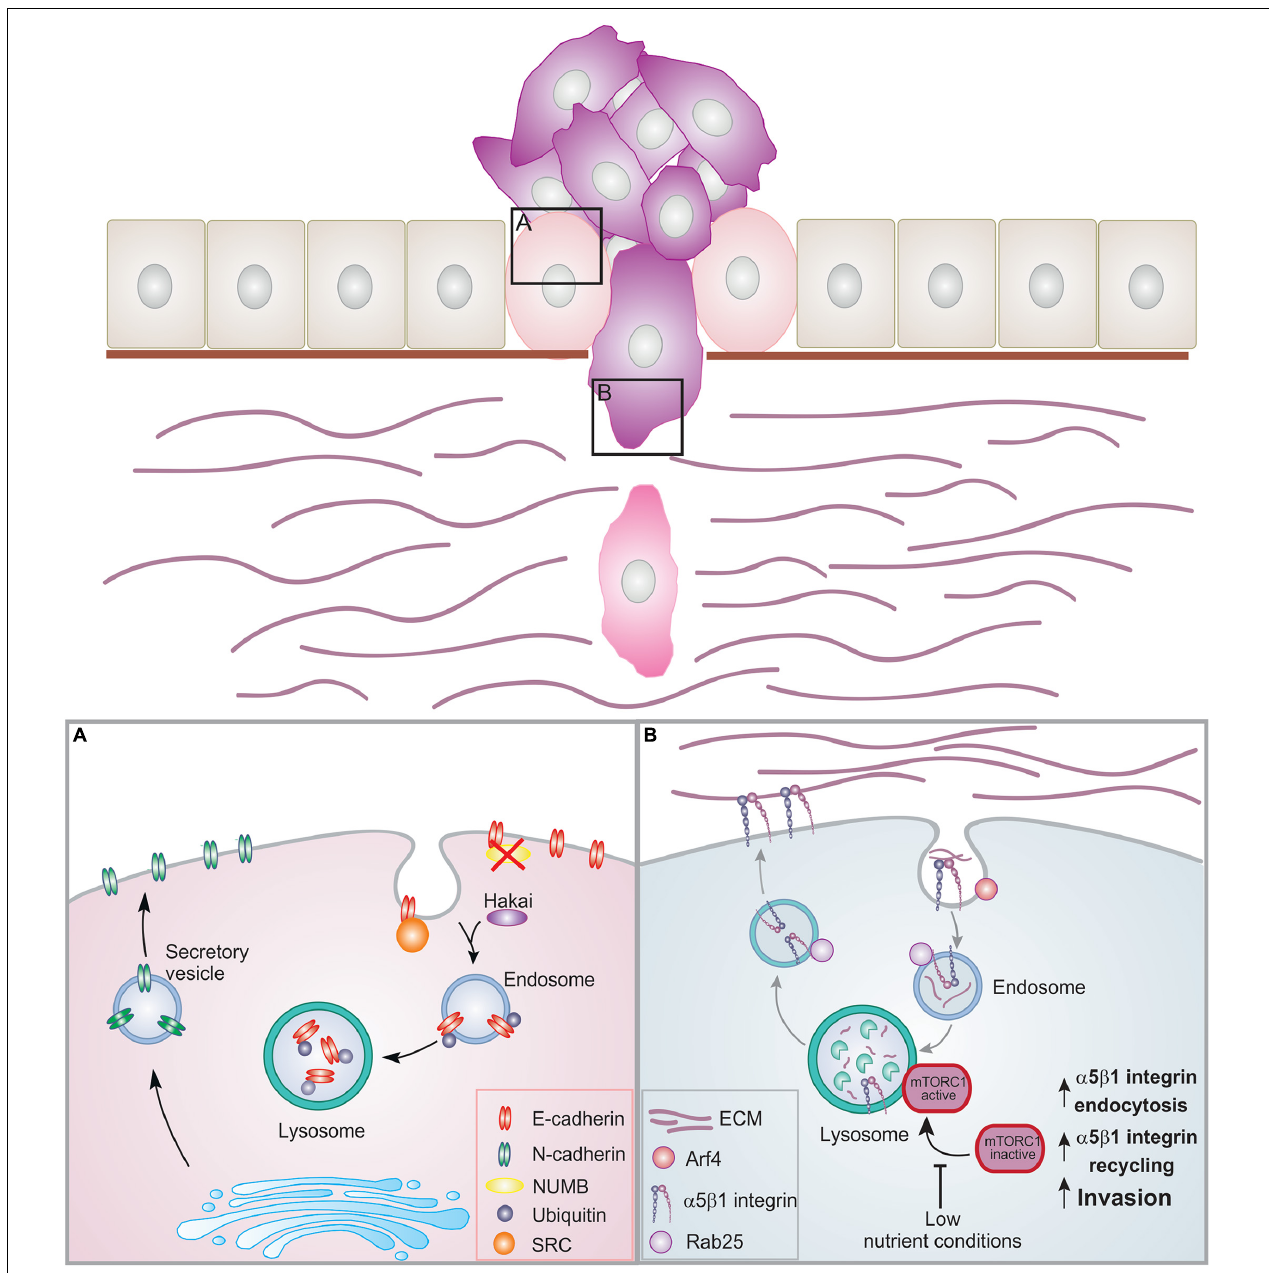
FIGURE 2 | Membrane trafficking events in EMT and cell invasion. Epithelial cells are organized in layers by establishing contacts with neighboring cells as well as the basement membrane. During cancer progression, the cells can lose these contacts leading to EMT and increased proliferation. Cancer cells can then acquire migratory ability, breaching through the basement membrane and invading into the ECM. (A) During EMT, E-cadherin is internalized and degraded. NUMB regulates the internalization and recycling of E-cadherin. When NUMB is lost, E-cadherin relocalizes to the apical side. Upon internalization, E-cadherin can be phosphorylated by src leading to ubiquitination by the E3 ligase Hakai. Ubiquitinated E-cadherin is delivered to lysosomes for degradation. This results in the loss of adherens junctions. N-cadherin is then transported to the surface promoting migration. (B) Trafficking of α 5 β 1 integrin under low nutrient conditions. Inhibition of the mTORC1 activation and of its recruitment to lysosomes promotes Arf4-dependent endocytosis, α 5 β 1 integrin recycling, and cell